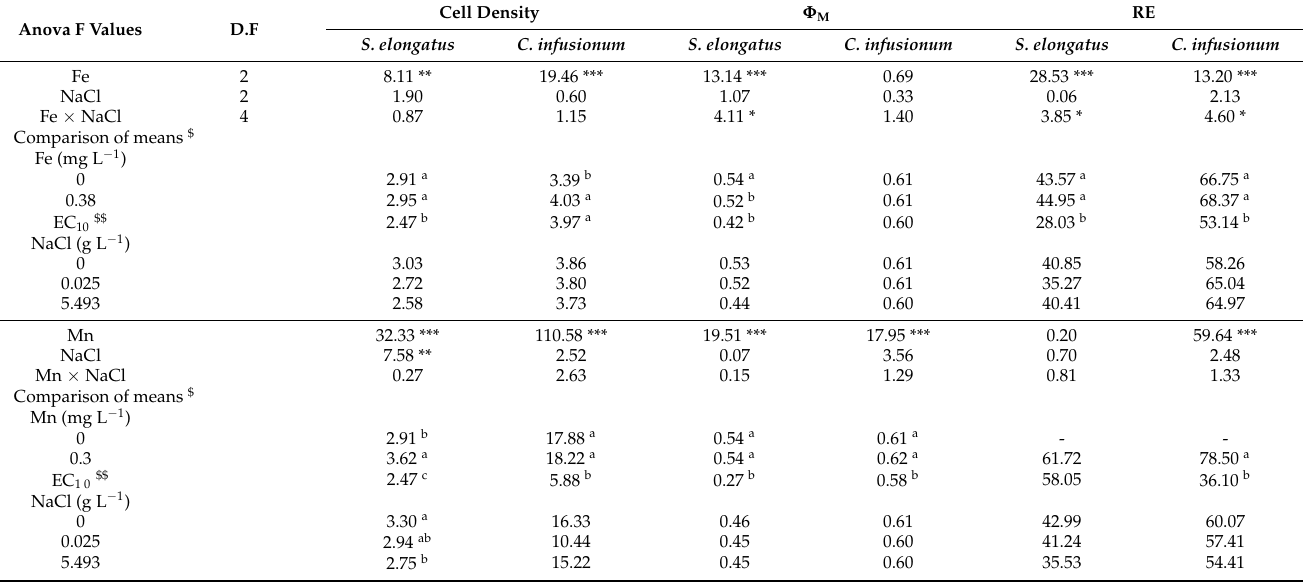
Table 3. F values and two-way ANOVA results for the effects of Fe/Mn and NaCl at different concentrations on cell density, maximal PSII photochemical yield ( Φ M ), and metal-removal efficiency (RE) on Synechococcus elongatus and Chlorococcum infusionum cells. Values represent the means of three replicates